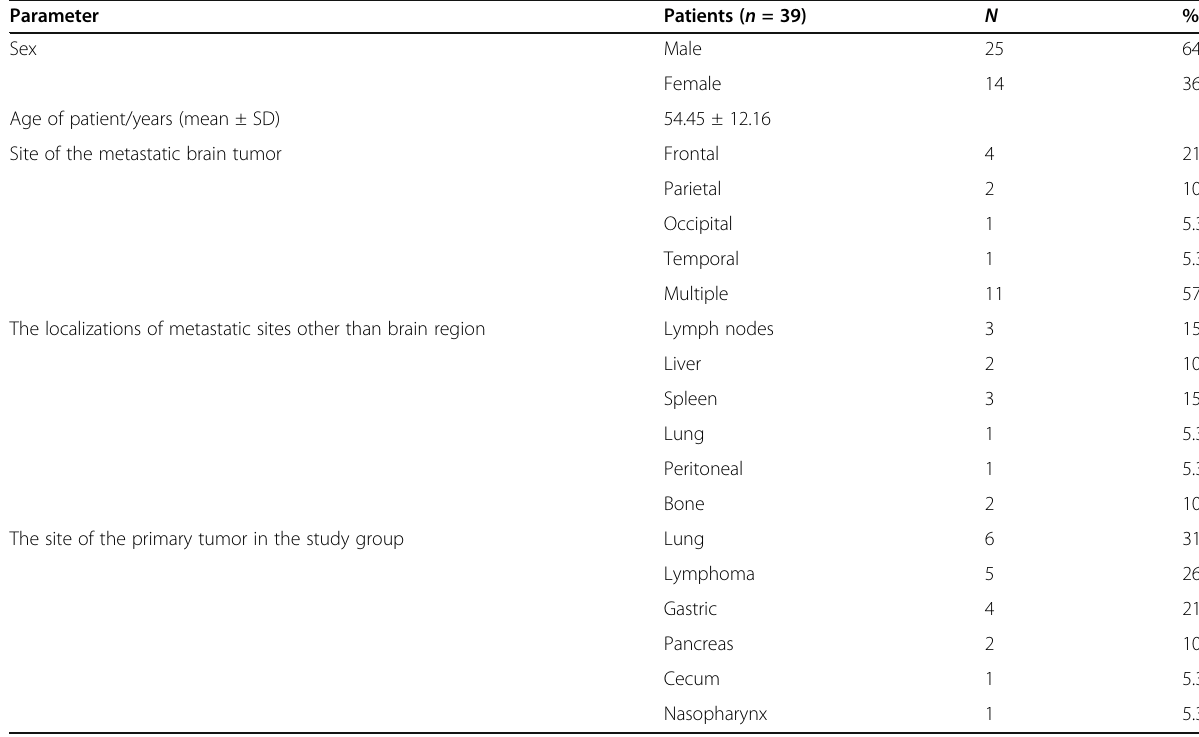
Table 1 Patient ’ s clinico-pathologic characteristics Parameter